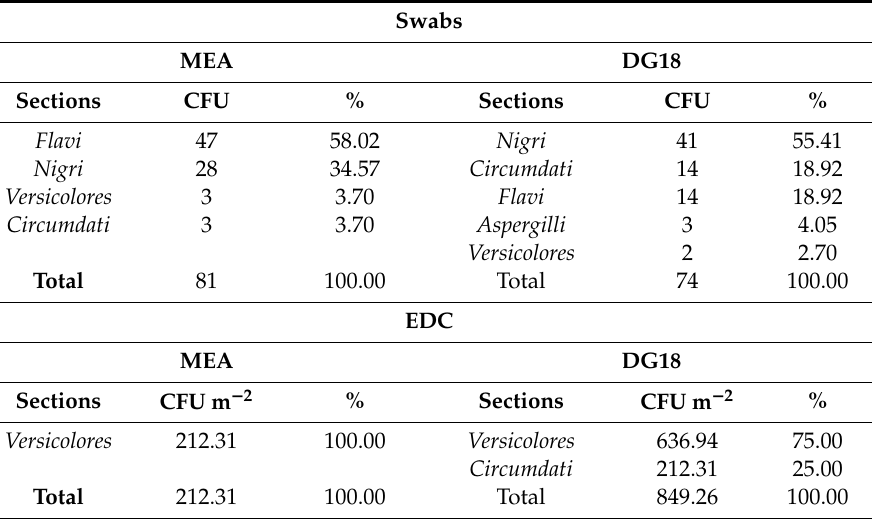
Table 5. Aspergillus section distribution on swabs and EDC.